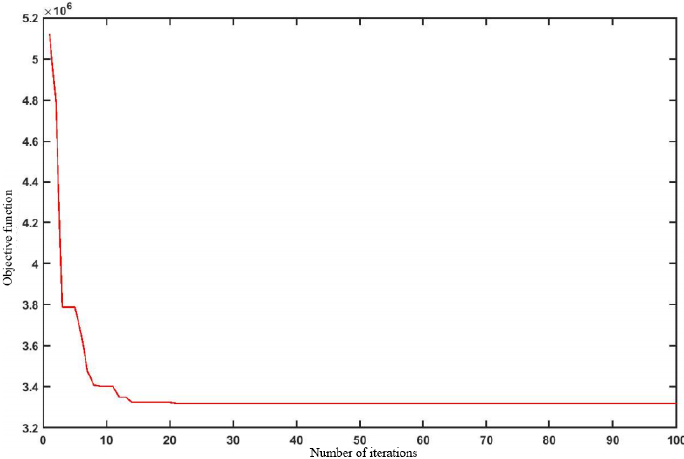
Figure 5. Optimized minimum value of sliding friction.